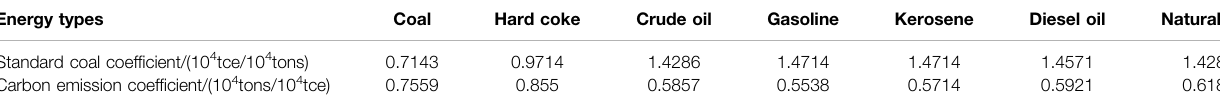
TABLE 1 | Carbon emission calculation parameters. Energy types